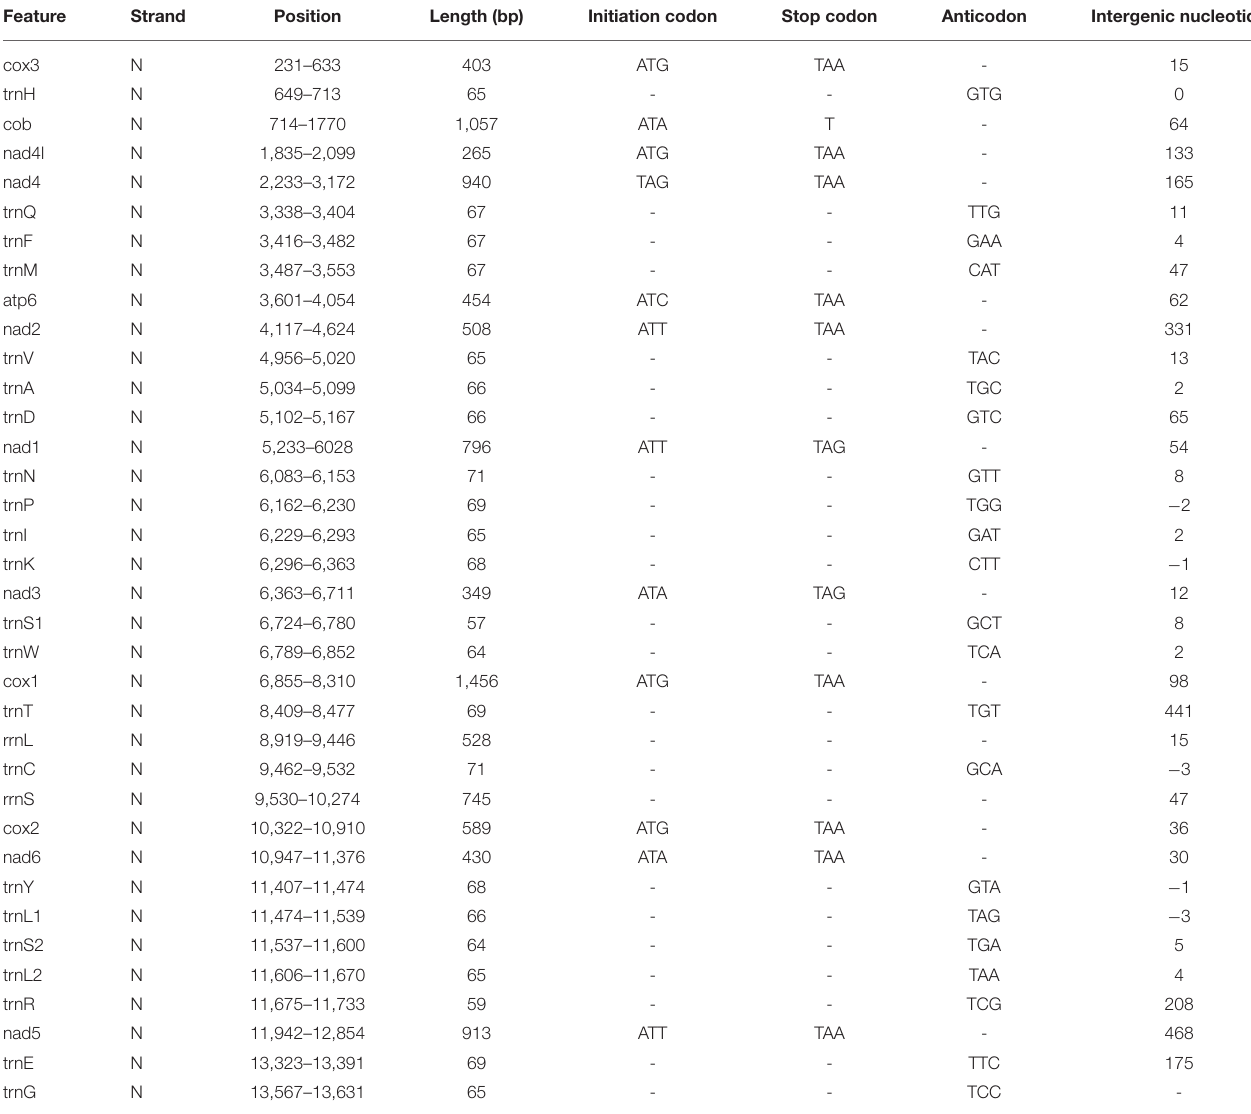
TABLE 1 | Position and nucleotide sequence lengths of mitochondrial genomes of F. intermediate , and start and stop codons for protein-coding genes as well as their tRNA gene anticodons. Feature